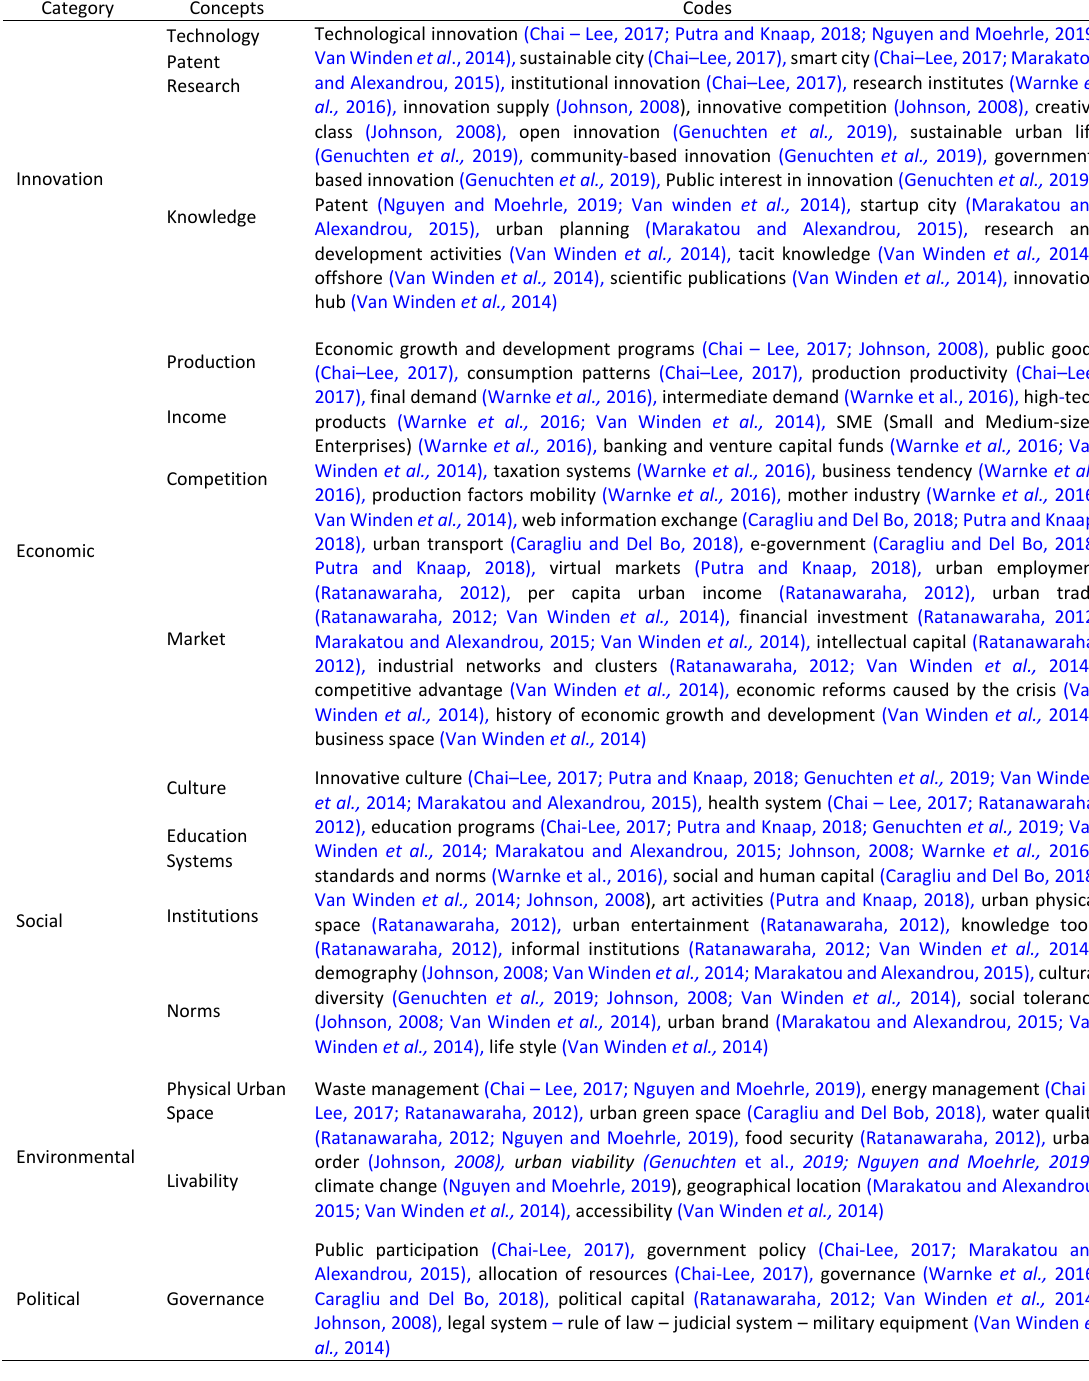
Table 4: Components for the realization of UIS